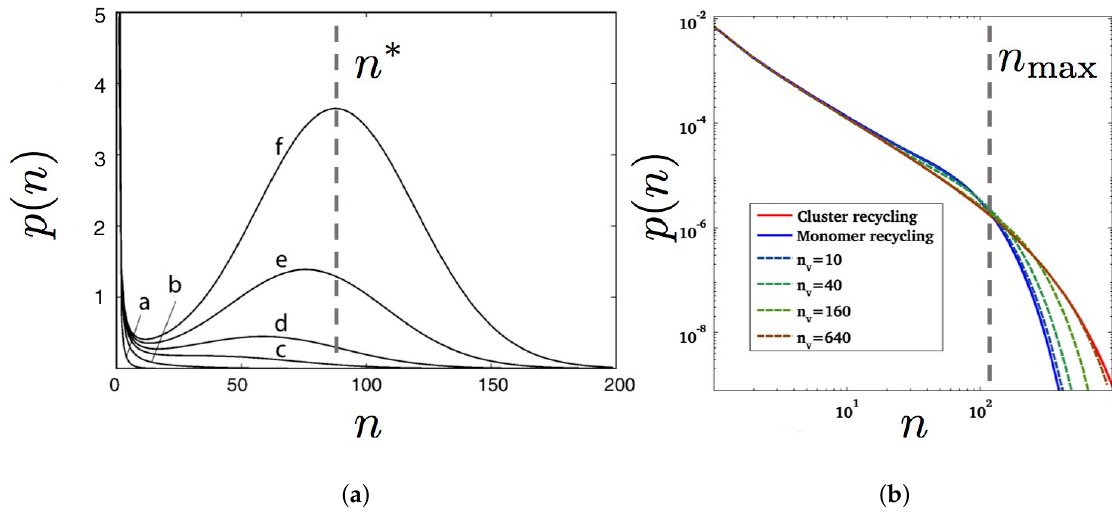
Figure 9. Examples of steady-state domain-size distributions p ( n ) . Here the domains are protein clusters. In these figures, their size is measured as the number n of proteins they contain, proportional to L 2 if L is the cluster radius. The units on the vertical axis are arbitrary. ( a ) Bimodal distributions, where small oligomers coexist with domains of typical size n ∗ (vertical dashed line for curve f). When going from curve “a” to curve “f”, the number of monomers in the membrane increases because more and more monomers are injected in the out-of-equilibrium membrane from the cytosol. Above a critical value, multimers nucleate and the distribution becomes bimodal as in curves “d”, “e” and “f”. The limit between monomodal and bimodal distributions is curve “c”. Adapted from [196]. ( b ) Power-law distributions p ( n ) ∝ n − 3/2 with a cut-off n max (vertical dashed line) above which p ( k ) decreases exponentially. Here the coalescence rate between two clusters is independent of their size. Clusters smaller than a size n v are recycled entirely as a whole, while larger clusters are fragmented and lose an area n v during a recycling event. The “whole cluster recycling” limit corresponds to n v and the “monomer recycling” limit to n v = 1. Adapted from [201]. For both figures, see the cited references for more details on the recycling